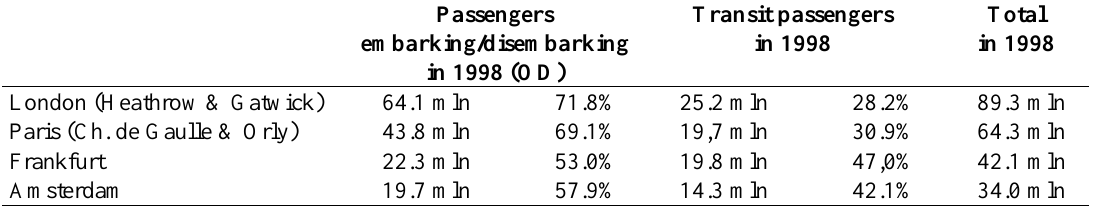
Table 3. Passengers of the main European airports, per market segment, 1998